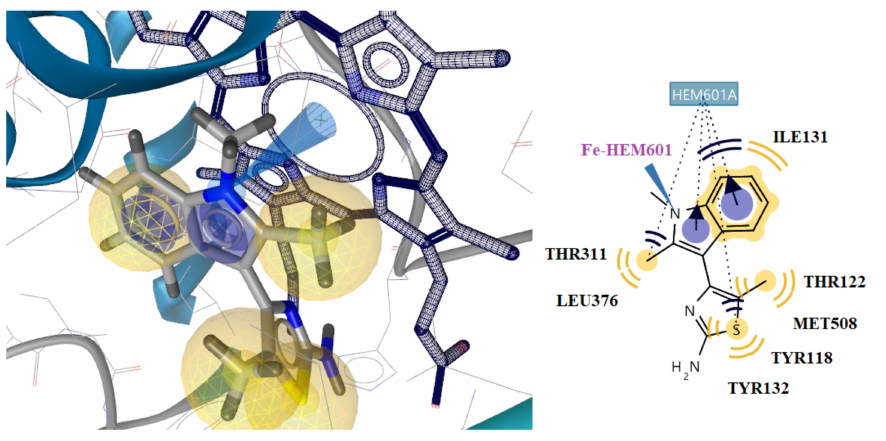
Figure 9. Docking of the most active compound 5r to CYP51 Ca receptor. Red and green dotted arrows indicate H-bond, blue arrows aromatic interactions and yellow spheres hydrophobic interactions.